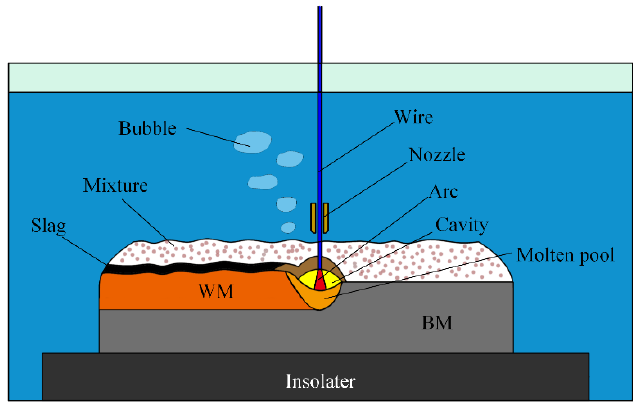
Table 2. Chemical composition of base metal and weld metal.